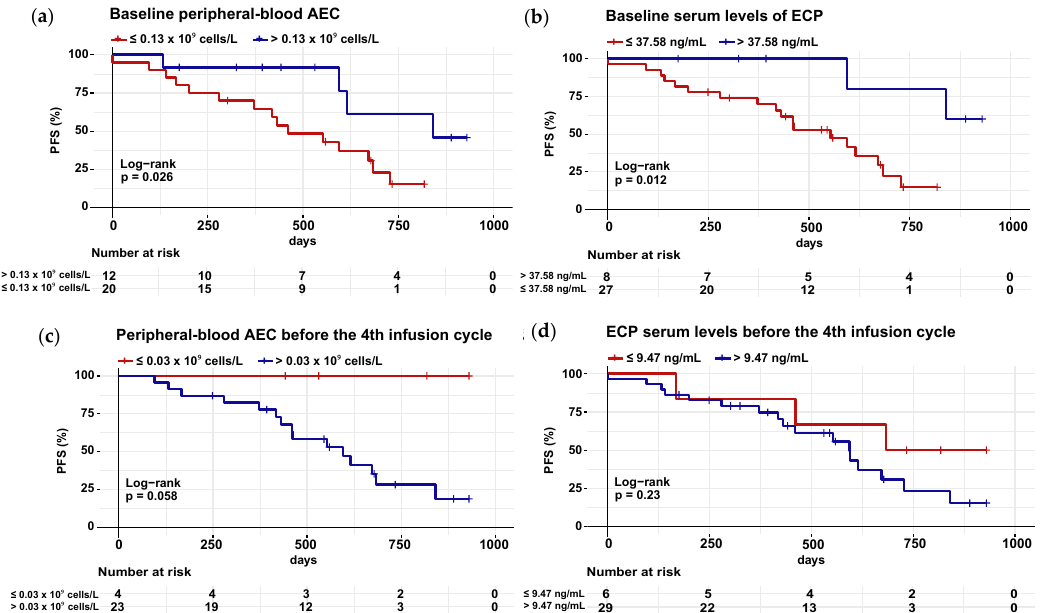
Figure 5. Elevated baseline peripheral blood AEC and ECP serum levels are associated with extended PFS in stage III and IV melanoma patients treated with ICI. Blood was taken before the start of ICI (baseline) and shortly before the respective infusion cycle of ICI (1st cycle, C1; 2nd cycle C2; 3rd cycle C3, 4th cycle C4; etc.). For our concentration measurements, we used serum at baseline and C4; Kaplan–Meier survival curves for PFS of advanced staged melanoma patients were stratified by the amount (high vs. low) of peripheral-blood AEC and ECP serum levels. p -values were calculated by the two-sided log-rank test; ( a ) Survival analyses for PFS of advanced melanoma patients with elevated (>0.13 × 10 9 cells/L) baseline AEC versus those with low peripheral blood AEC; ( b ) Survival analyses for PFS of advanced melanoma patients with elevated (>37.58 ng/mL) baseline ECP serum levels versus those with low ECP levels; ( c ) Survival analyses for PFS of advanced melanoma patients with elevated (>0.03 × 10 9 cells/L) C4 AEC versus those with low peripheral blood AEC; ( d ) Survival analyses for PFS of advanced melanoma patients with elevated (>9.47 ng/mL) C4 ECP serum levels versus those with low ECP levels. Abbreviations: AEC: absolute eosinophil count; ECP: eosinophil cationic protein; PFS: progression-free survival; ICI: immune checkpoint inhibition; C4: 4th infusion cycle; p : p